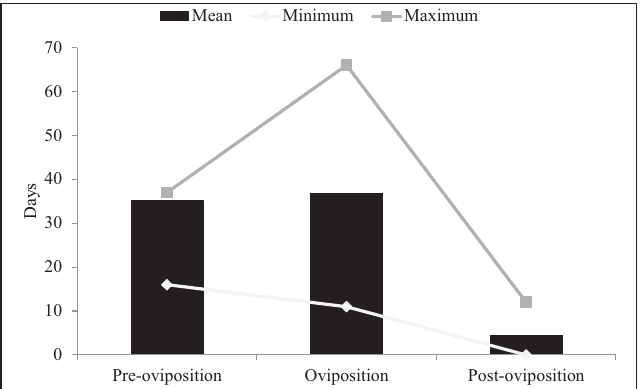
Fig. 1. Minimum, maximum, and mean duration of the pre-ovi- position, oviposition, and post-oviposition periods of Gryllus as- similis (Orthoptera: Gryllidae) in the laboratory (N = 50